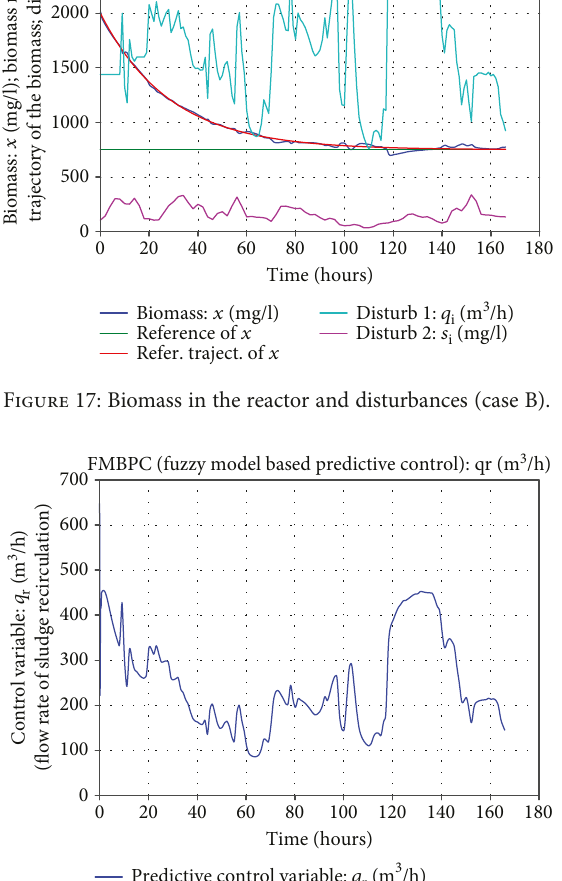
Figure 15: Activated sludge recirculation fl ow rate: the calculated predictive control variable (case A).